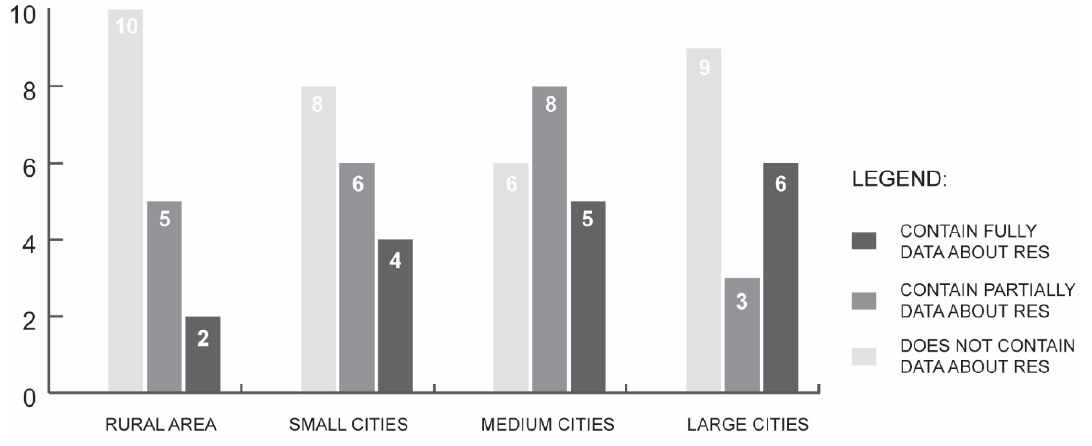
Figure 8. Share of individual identified types of local spatial development plans in communes of different sizes and statuses. Source: own